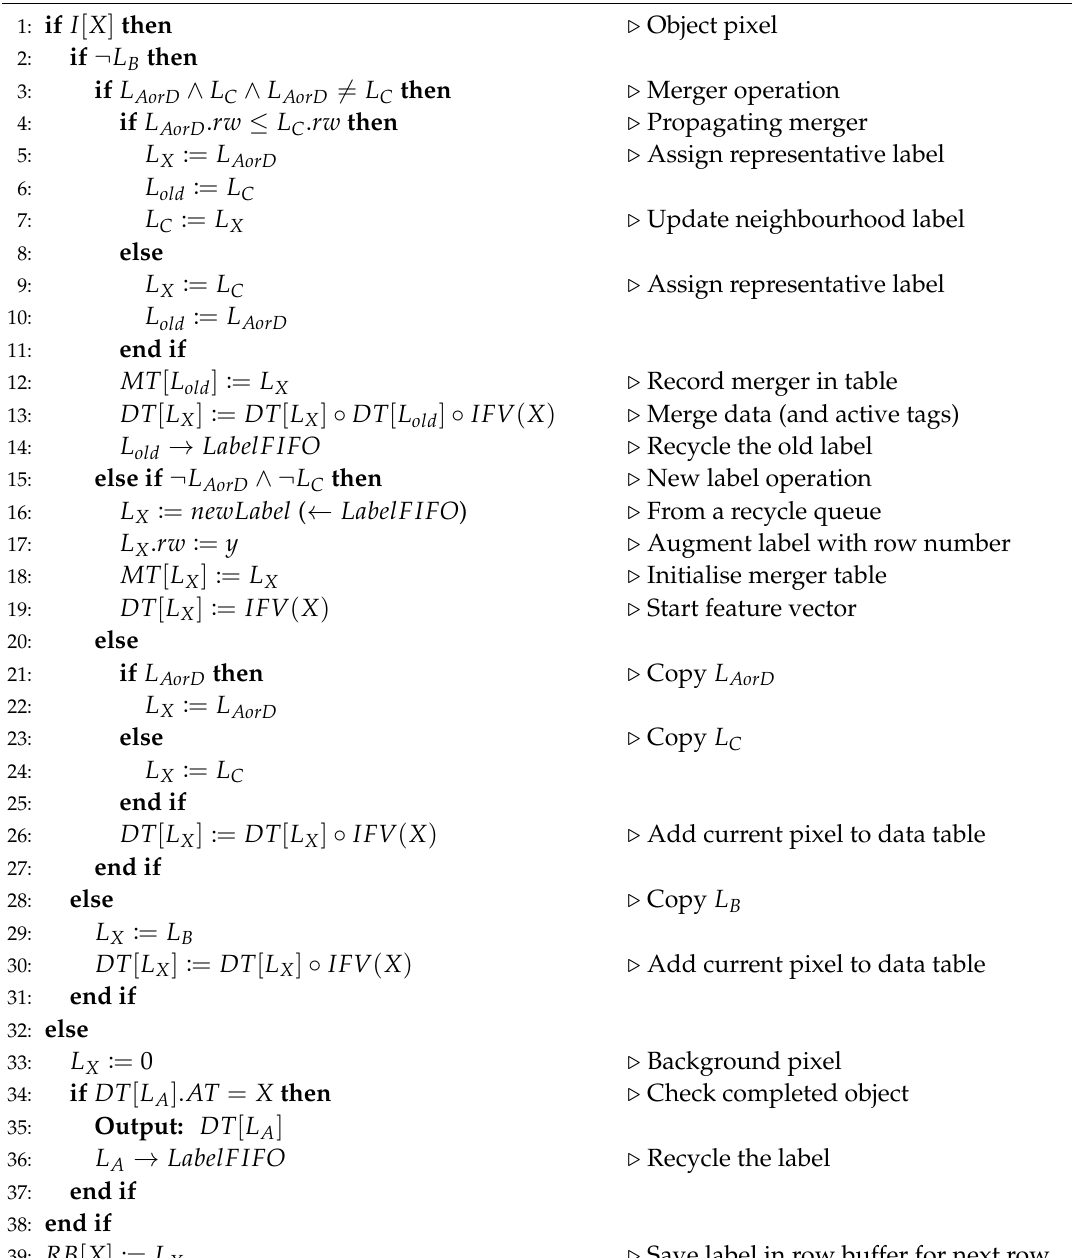
Algorithm 4 U PDATE D ATA S